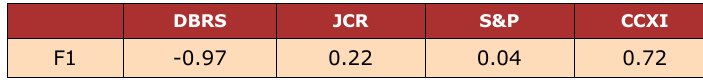
Table 6. The Assessment Value of Industry Control